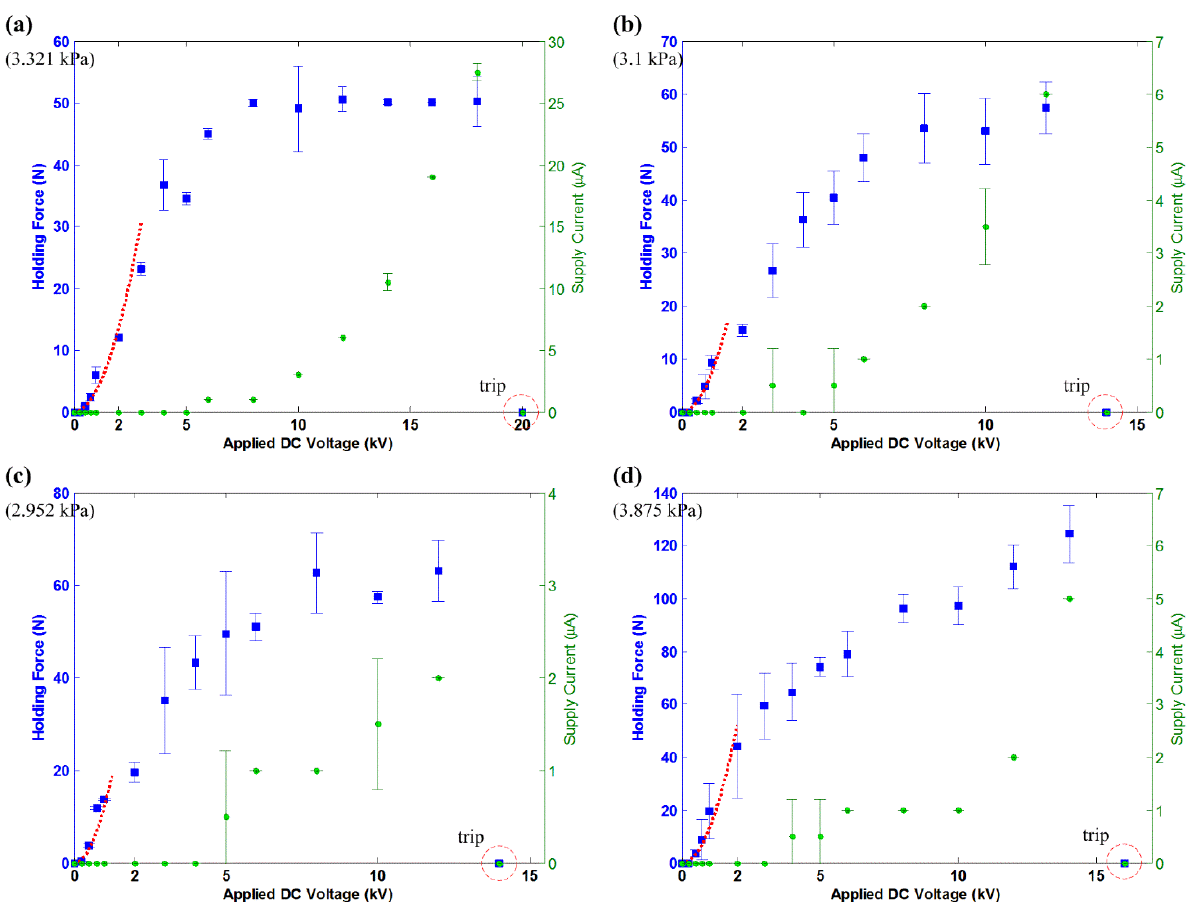
Figure 9. The measured holding force and supply current for the electroadhesion actuators on ceramic tiles, shown with the tripped voltage level. The dashed line describes a quadratic fit over the data, which follows Equation (13). ( a ) B7×4, c = 3.4; ( b ) B7×5,